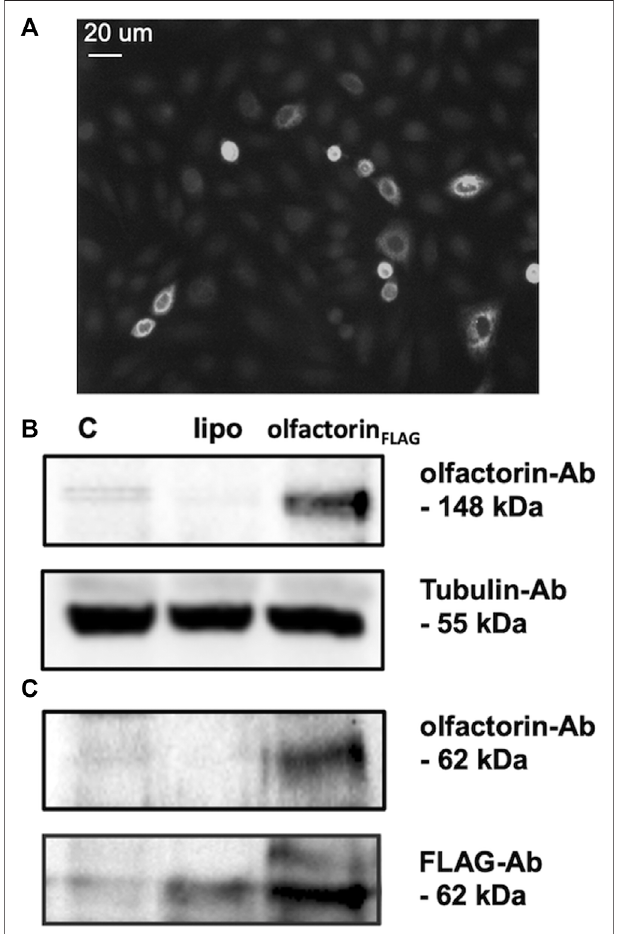
FIGURE2| Identi fi cationofolfactorininCOS-7cellstransfectedwiththe pCMV Sport6.1-FLAG-BQ887653 mouse Umodl1 expression vector. (A) Immuno fl uorescence detection of olfactorin with an anti-FLAG antibody in COS-7 cells transfected with the pCMV Sport6.1-FLAG-BQ887653 vector. (B) Olfactorin expression in COS-7 cells was evaluated by WB after 48 h of transfection. In protein extracts (olfactorin FLAG ), a full-length olfactorin (148 kDa) detected with olfactorin-serum (olfactorin-Ab) was overexpressed; (C) in the CM of transfected cells the secreted form of olfactorin (62 kDa) was detected by both anti-olfactorin-serum and anti-FLAG-Ab. Experiments were performed independently three times, and a representative blot is shown. C: untrasfected cells; lipo: cells transfected with an empty vector.